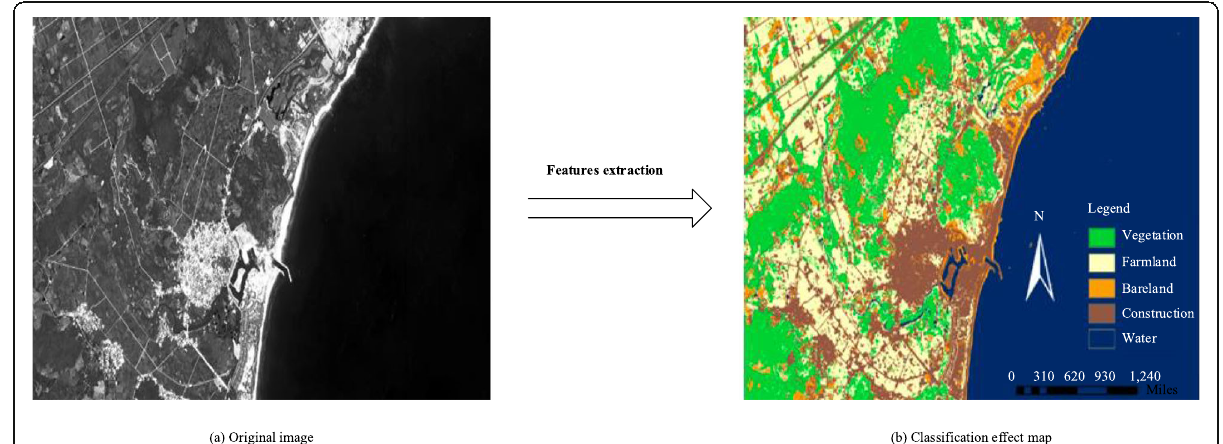
Fig. 6 Classification effect map of GF-2 image obtained by